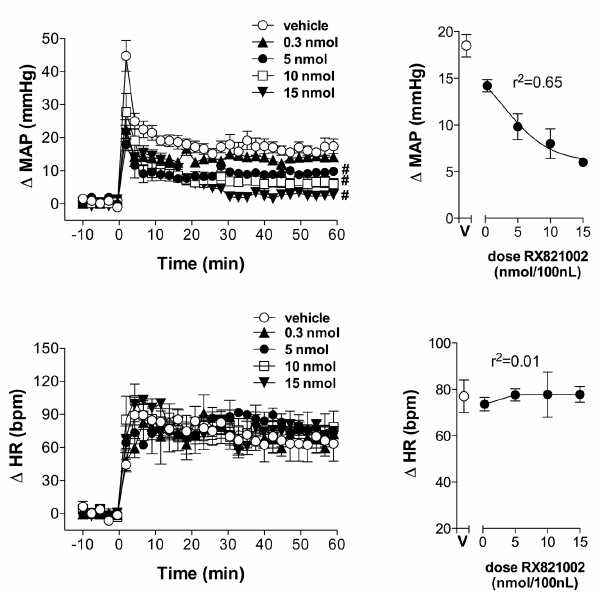
Figure 4. Changes in mean arterial pressure ( D MAP) and heart rate ( D HR) evoked by acute restraint stress in animals treated with different doses of the selective a 2 -adrenoceptor antago- nist RX821002 into the insular cortex. (Left) Time-course of D MAP and D HR during acute restraint stress in rats treated with vehicle (ACSF, 100 nl, n=6) or different doses (0.3, 5, 10 and 15 nmol/100 nl, n=5/ group) of the selective a 2 -adrenoceptor antagonist RX821002 into the insular cortex. The onset of exercise was at t=0. Circles represent the mean and bars the S.E.M. # P , 0.05, indicates a significant difference over the whole restraint stress period compared to vehicle treated animals; ANOVA followed by Bonferroni’s post test. (Right) D MAP and D HR during restraint stress in rats treated with increasing doses of RX821002 (0.3, 5, 10 and 15 nmol/100 nl). V: vehicle (ACSF, 100 nl). Dose–effect curves were generated by nonlinear regression